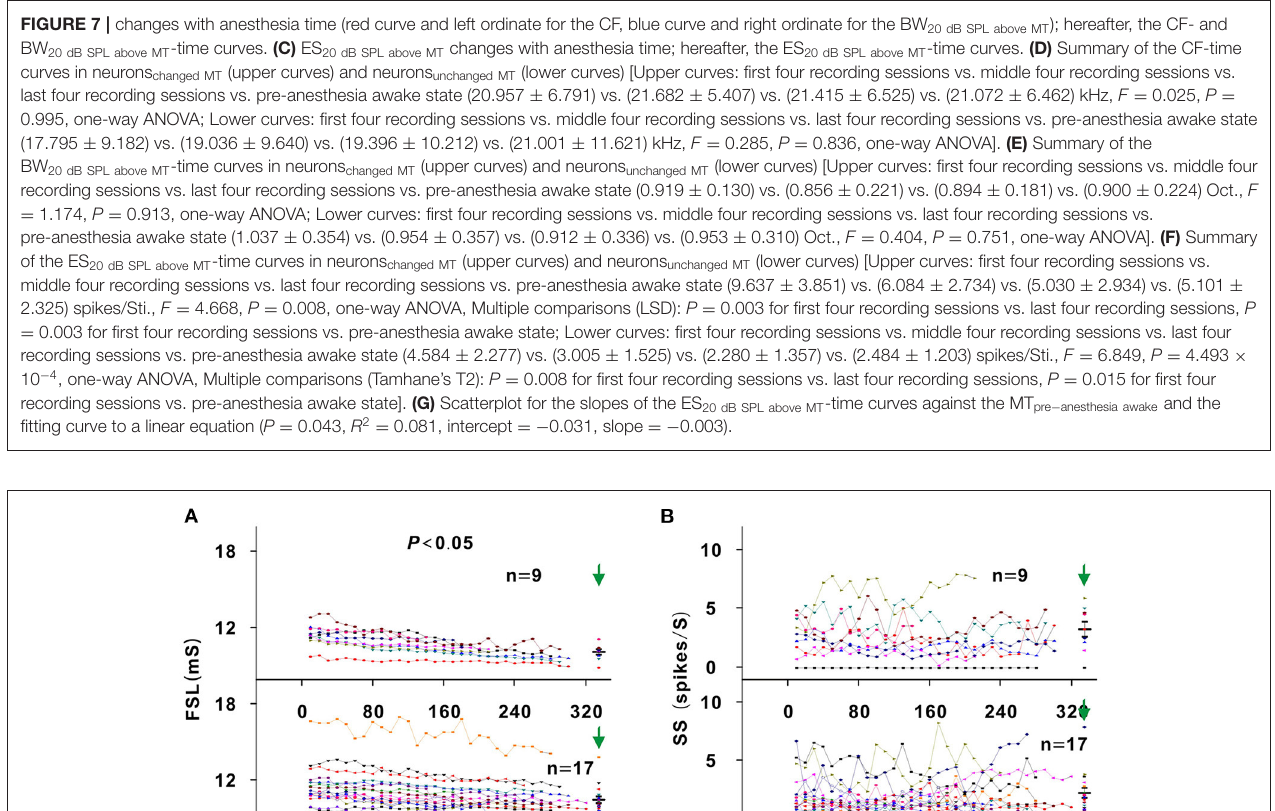
FIGURE 8 | Changes in the FSL and SS of neurons. (A) Summary of FSL changes with anesthesia time in neurons changed MT (upper curves) and neurons unchanged MT (lower curves) [Upper curves: first four recording sessions vs. middle four recording sessions vs. last four recording sessions vs. pre-anesthesia awake state (11.454 ± 0.888) vs. (10.674 ± 0.697) vs. (10.158 ± 0.642) vs. (10.123 ± 0.621) ms, F = 6.702, P = 0.001, one-way ANOVA, Multiple comparisons (LSD): P = 0.001 for first four recording sessions vs. last four recording sessions, P = 4.356 × 10 − 4 for first four recording sessions vs. pre-anesthesia awake state; Lower curves: first four recording sessions vs. middle four recording sessions vs. last four recording sessions vs. pre-anesthesia awake state (11.622 ± 1.612) vs. (11.044 ± 1.447) vs. (10.755 ± 1.234) vs. (10.497 ± 1.096) ms, F = 2.140, P = 0.104, one-way ANOVA]. (B) Summary of SS changes with anesthesia time in neurons changed MT (upper curves) and neurons unchanged MT (lower curves) [Upper curves: first four recording sessions vs. middle four recording sessions vs. last four recording sessions vs. pre-anesthesia awake state (2.751 ± 1.654) vs. (2.479 ± 1.783) vs. (2.765 ± 2.175) vs. (3.298 ± 1.919) spikes/S, F = 0.295, P = 0.829, one-way ANOVA; Lower curves: first four recording sessions vs. middle four recording sessions vs. last four recording sessions vs. pre-anesthesia awake state (2.060 ± 1.554) vs. (1.725 ± 1.182) vs. (2.086 ± 1.628) vs. (2.178 ± 1.765) spikes/S, F = 0.279, P = 0.841, one-way